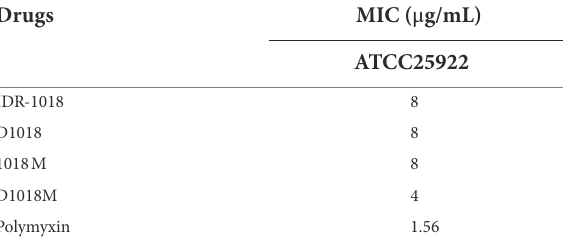
TABLE 1 The MICs of IDR-1018, D1018, 1018M, D1018M, and polymyxin against E. coli ATCC25922.